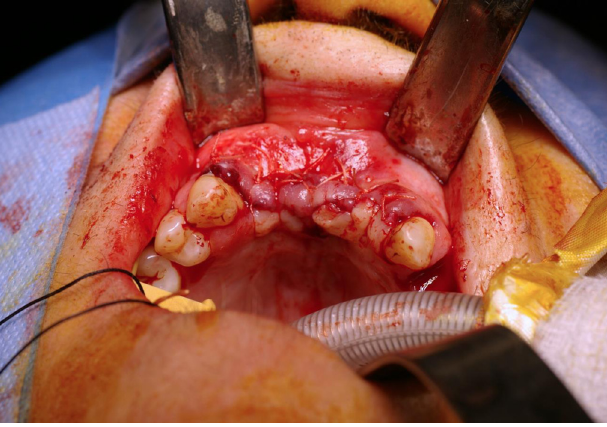
Fig. 4. Vestibular view after realising the